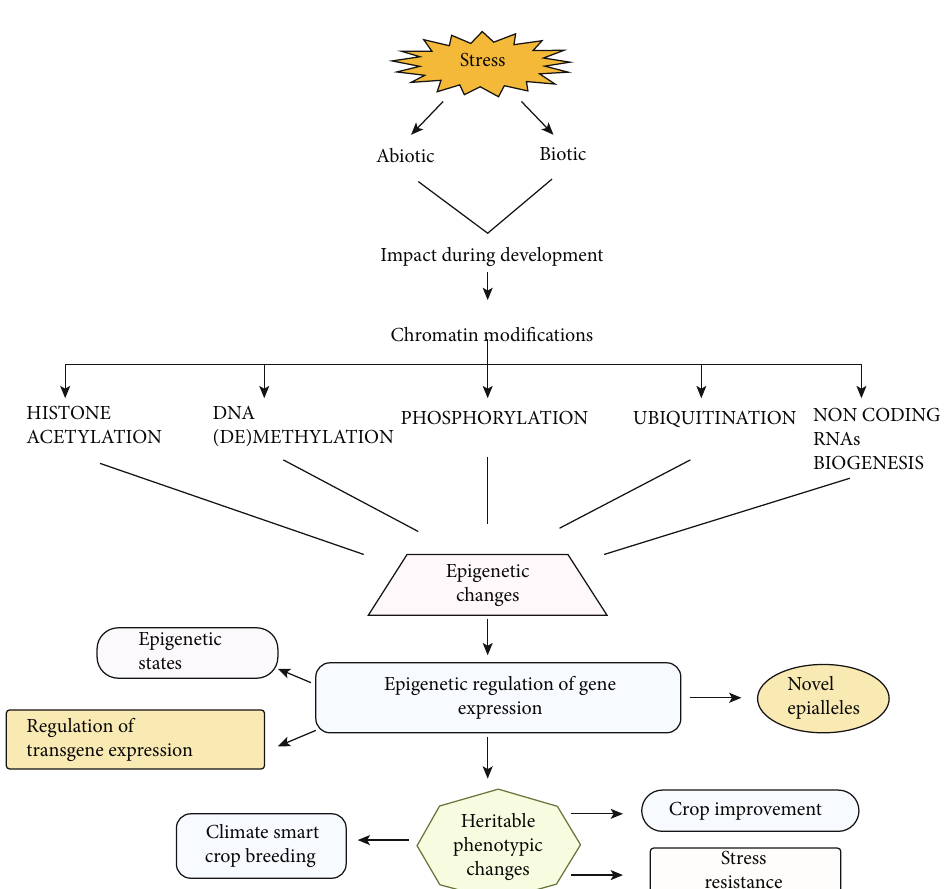
Figure 1: Epigenetic changes in plants under stress. Plants withstand various environmental stresses throughout their developmental stages and to overcome these challenges, epigenetic modi fi cations play a vital role. These include covalent modi fi cations of histone tails (acetylation, methylation, phosphorylation, ubiquitination, and the small RNA machinery). Epigenetic changes are the heritable phenotypic variations that are not always due to speci fi c DNA sequence alterations, but the epigenetic regulation that involves certain chemical modi fi cations at the molecular level which can alter the gene expression. DNA and chromatin modi fi cations at the epigenomic level a ff ect gene expression and play a prominent role in unveiling phenotypic responses against external stimuli. Epigenetic changes are reversible and heritable to control gene expression without any change in the DNA sequence. Epigenetics holds immense potential in crop improvement strategies, climate-smart breeding and stress resistance by choosing the favorable epigenetic states, formulation of novel epialleles, and regulation of transgene